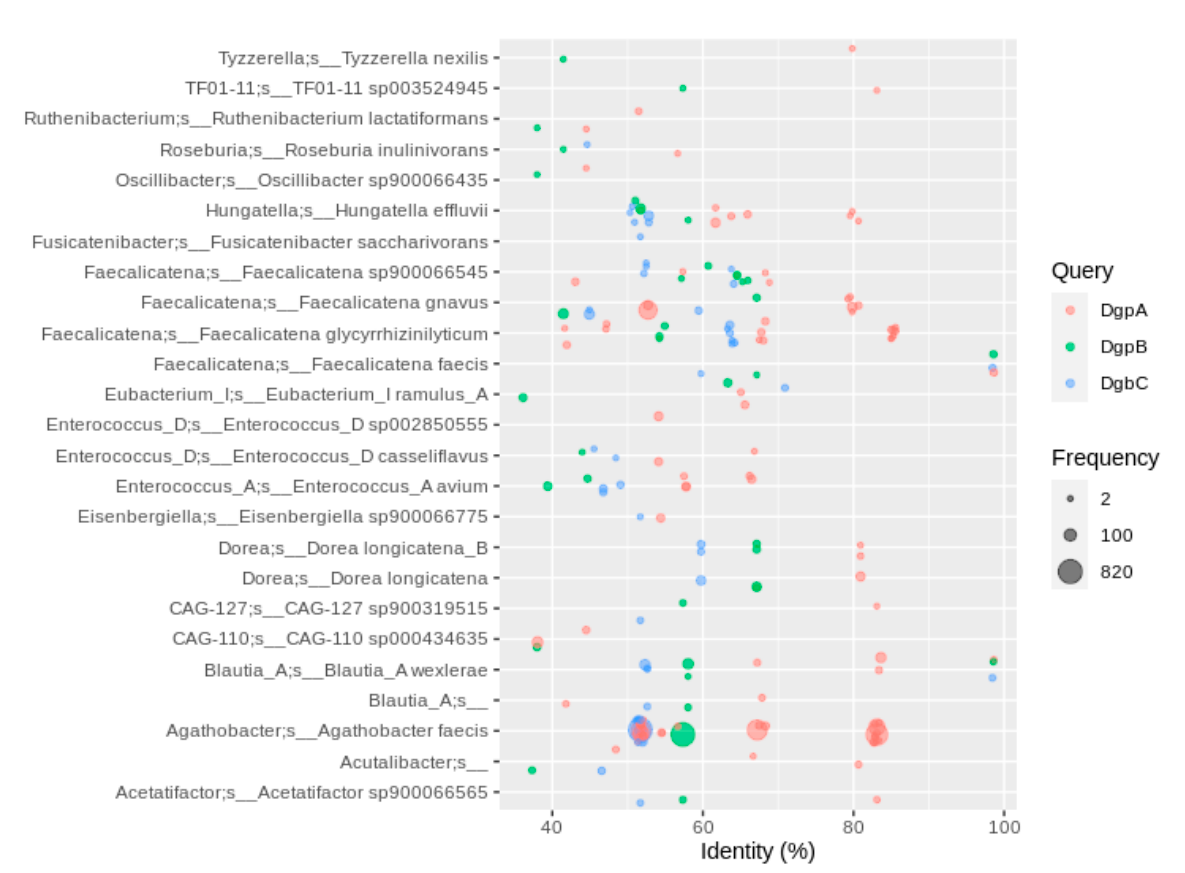
Figure 4. Homologs to enzymes involved in flavonoid C -degylcosylation using sequences of strain PUE. Hits were filtered for the co-occurrence of all three genes required for C -deglycosylation ( dgpABC ) in the same MAG. Hits were filtered for at least 2 occurrences, so that each bubble represents a number of redundant sequences ranging from 2 to 820.